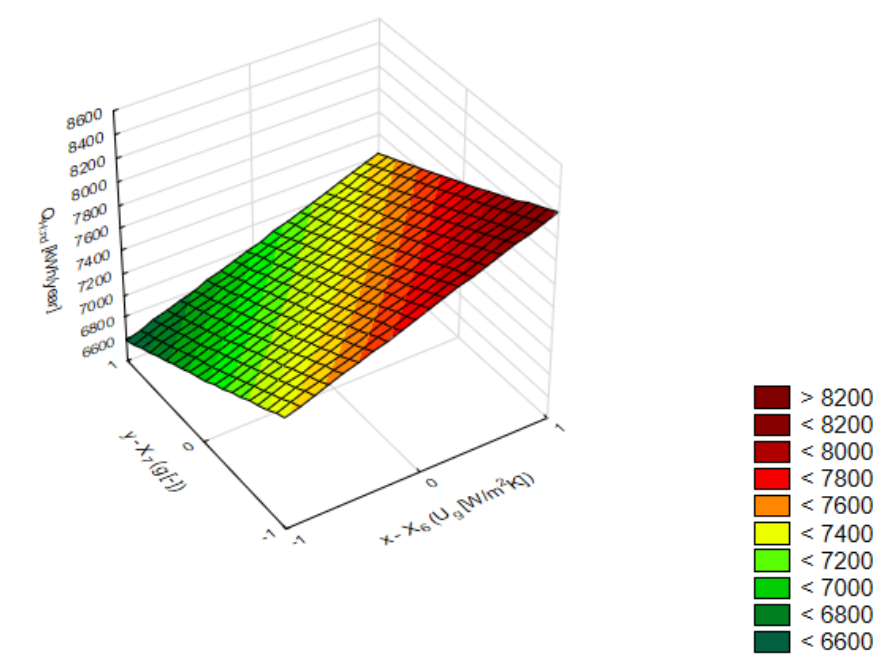
Figure 13. Dependence of Q Hnd on the factors from the third group of parameters, i.e., physical, regarding window solutions: X 6 —the heat transfer coefficient of the glazing U g and X 7 —the total transmittance of solar radiation energy of the glazing g .